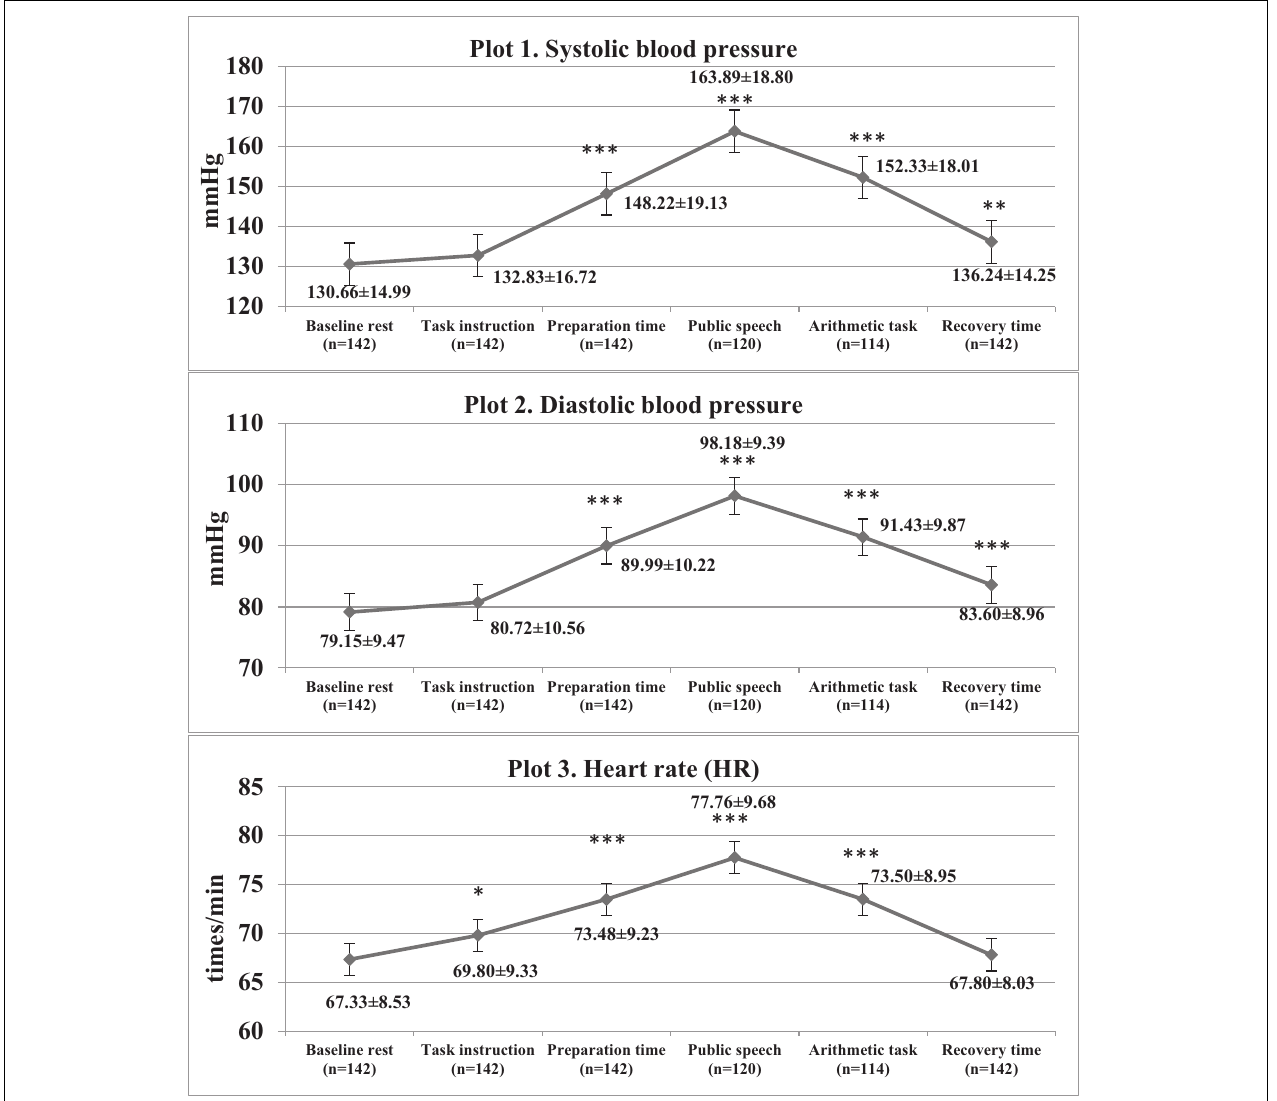
FIGURE 1 | Descriptive statistics of cardiovascular characteristics and comparison with baseline cardiovascular measures during Trier Social Stress Test in the study patients. ∗ p < 0.05, ∗∗ p < 0.01, ∗∗∗ p < 0.001 as compared with baseline